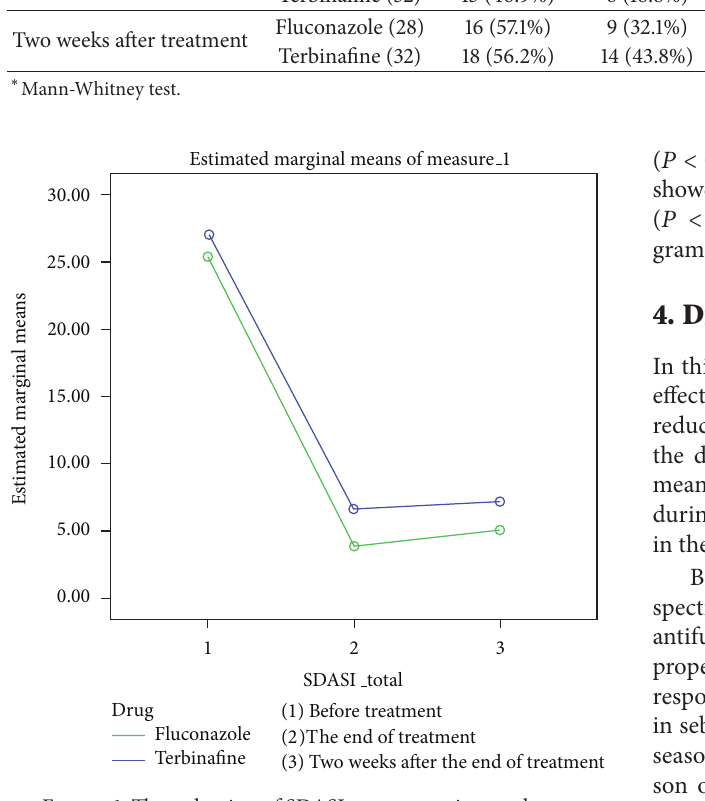
Figure 1: The reduction of SDASI parameters in two